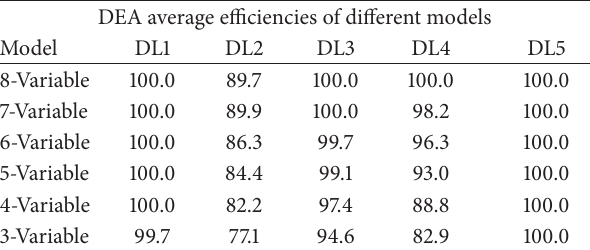
Table 4: Average efficiency scores by model.